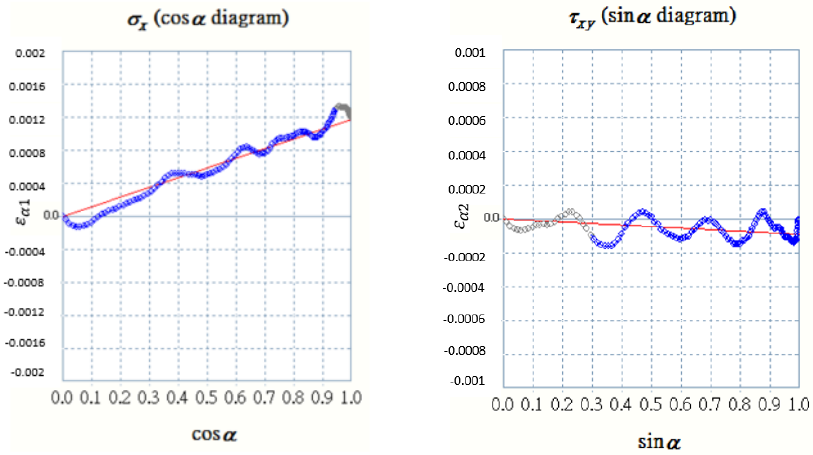
Figure 15. Variations of ε α 1 and ε α 2 with respect to cos α and sin α for a laser power of 900 W. According to the calculation of the slopes in Figures 13–15, the measurements of the residual stresses are shown in Figure